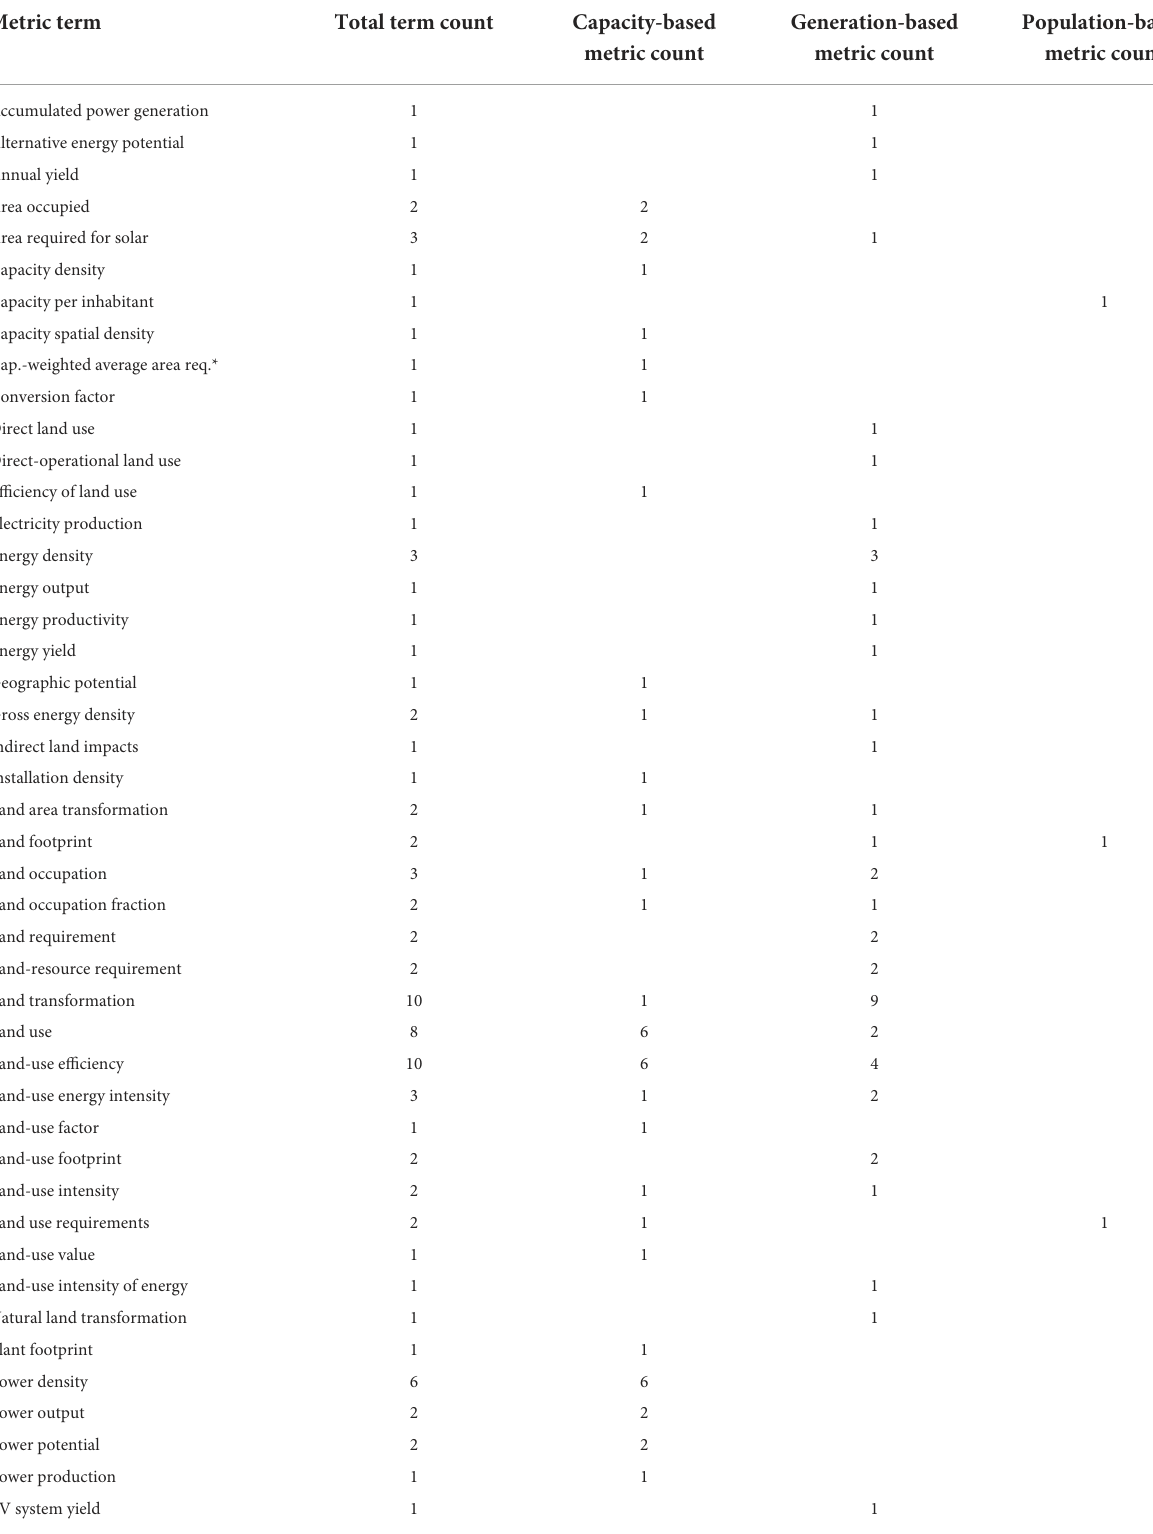
TABLE 2 Solar energy-land metric terms by total count and category type. Metric term Total term count Capacity-based